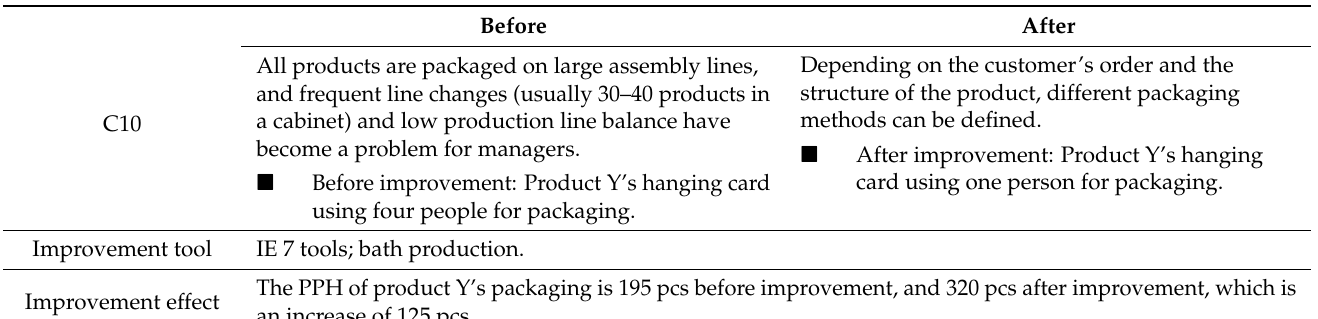
Table 14. C10 improvement project and its improvement effects (before and